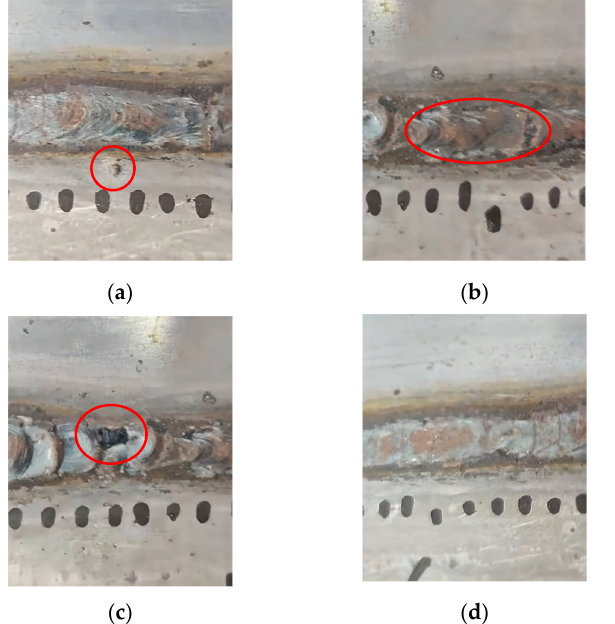
Figure 1. The pictures show three kinds of defects and a sample with no defects: ( a ) burr, ( b ) concave, ( c ) porosity, ( d ) no defects.